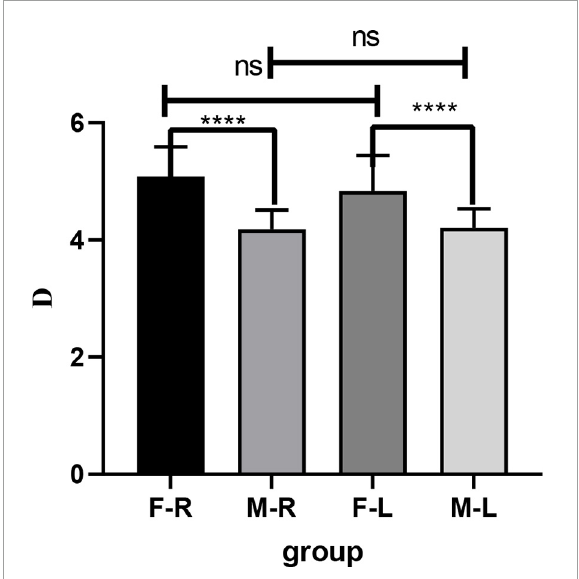
FIGURE3 Comparison of RE in Sprague Dawley (SD) rats of different sexes and eye types. F-R, female group right eye; M-R, male group right eye; F-L, female group left eye; M-L, male group left eye; RE, refractive errors; D, diopter; ns indicates no statistical significance; **** p <